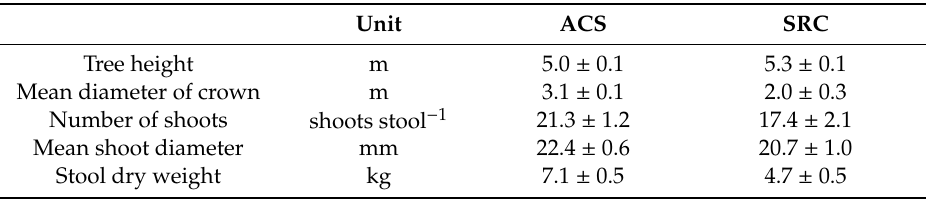
Table A4. Cumulated annual respiration rates in the two systems (g C m − 2 year − 1 , average ± SE; ACS: Alley Cropping System; SRC: Short Rotation Coppice system). Values reported as Soil respiration (R s ), Heterotrophic respiration (R h ), Autotrophic respiration (R a ).